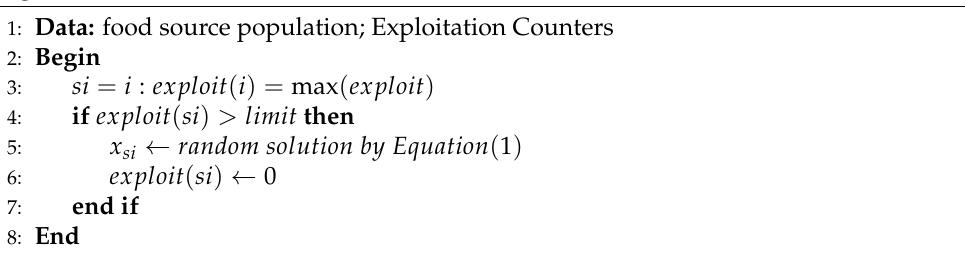
Algorithm 4 Scout Bees’ Labor Pseudocode (Modified from